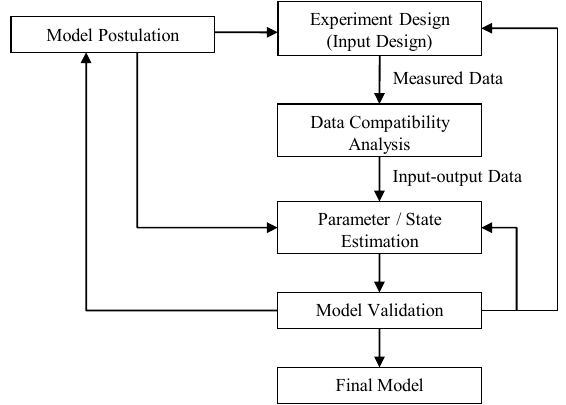
Figure 1. Flow chart of system identification process.